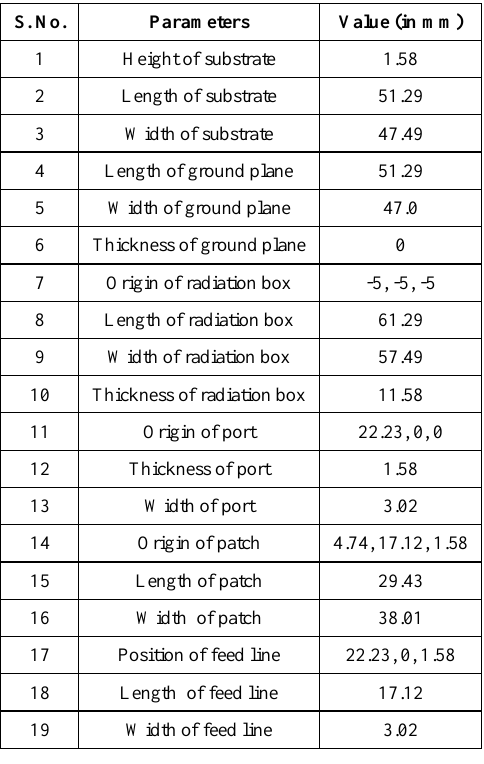
Table 1. Dimension of rectangular microstrip antenna